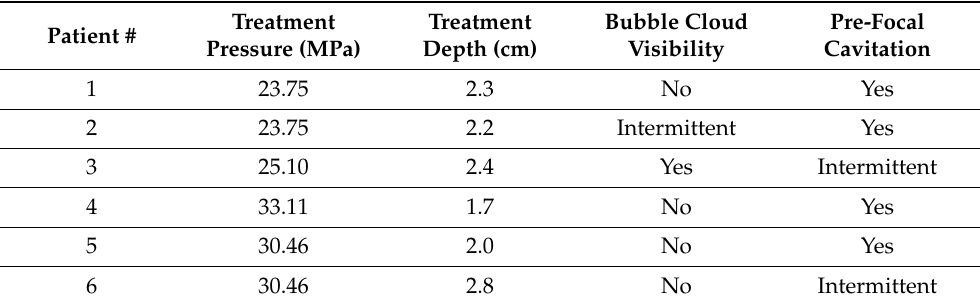
Table 2. Histotripsy treatment